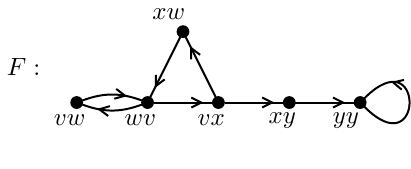
Figure 8: Illustrating root